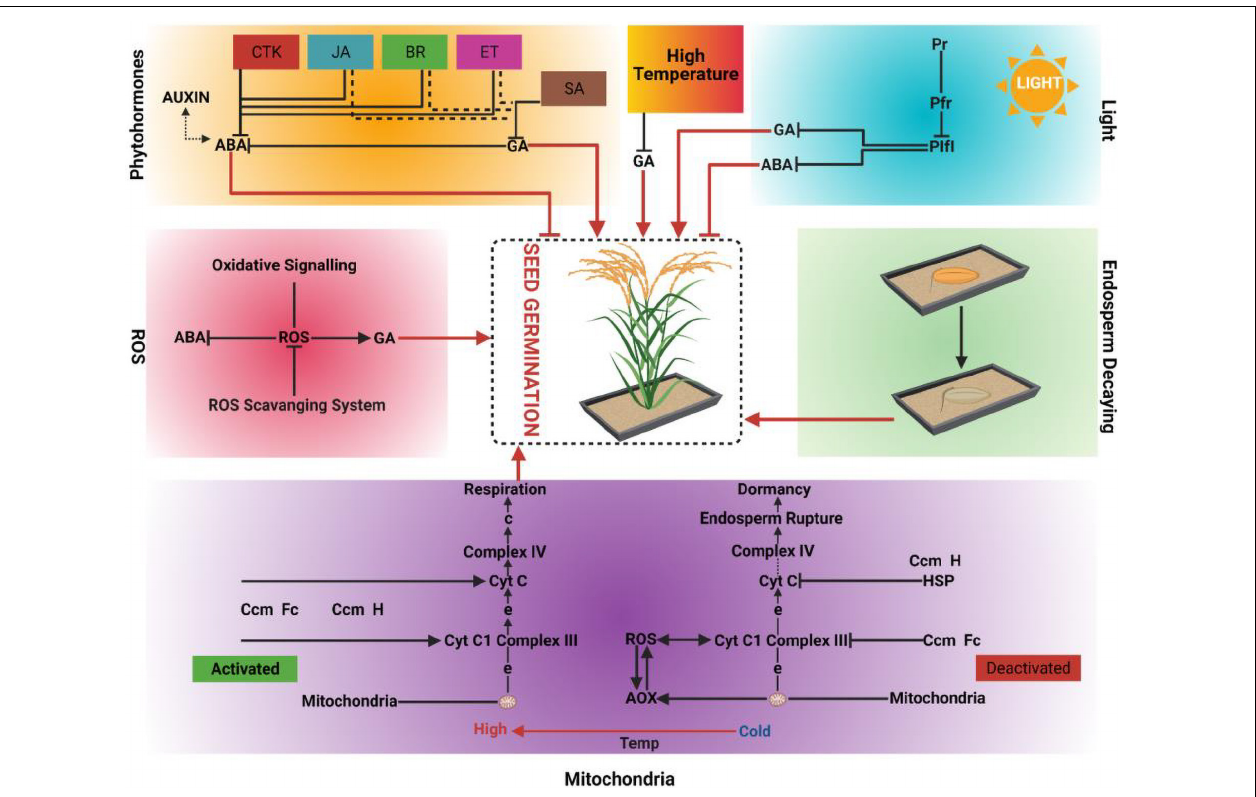
FIGURE 1 | Driving forces of seed germination; Phytohormones, High temperature, Light, Reactive oxygen species (ROS), Endosperm decaying and Mitochondria. CTK: Cytokinins, JA: Jasmonic acid, BR: Brassinosteroids, ET: Ethylene, SA: Salicylic acid, GA: Gibberellic acid, ABA: Abscisic acid, PIF1: Phytochrome Integrating Factor 1, Pfr: Photoreceptors far red, Pr: Photoreceptor red, Cyt c: Cytochrome c, AOX: Alternative oxidases, HSP: Heat shock proteins, ROS: Reactive oxygen species, Temp: